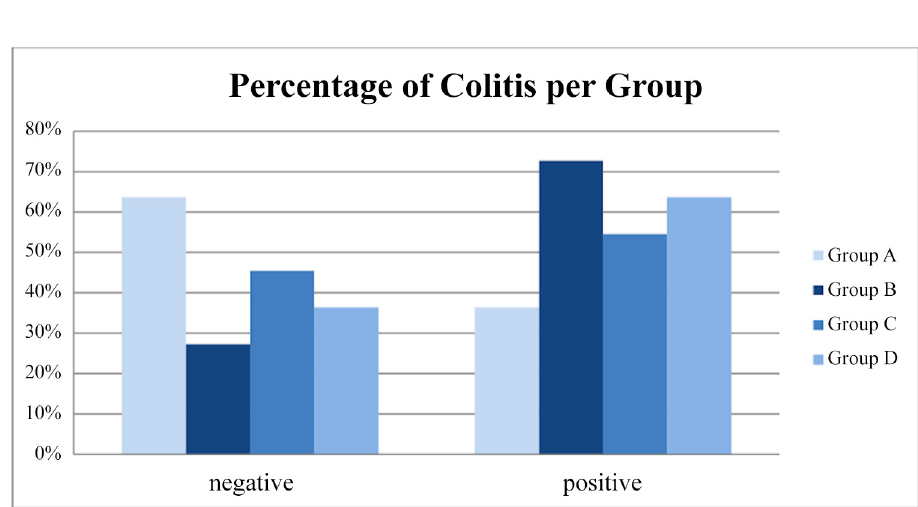
Fig 3. Percentage of specimens positive for colitis among all groups.